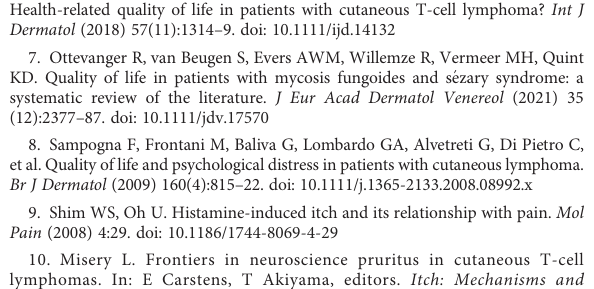
SUPPLEMENTARY FIGURE 1 Representative photos of a patient with mycosis fungoides. (A) An overview of a patient with MF and (B) A close-up of the arm, from which both skin biopsies of lesional and non-lesional skin were taken. SUPPLEMENTARY FIGURE 2 Mast cell numbers are increased in lesional skin of MF patients. Histological pictures of MC in Giemsa stainings are depicted of healthy control skin (A, B) , lesional skin (C, D) and non-lesional skin (E, F) of a representative MF patient. Pictures (A, C, E) are shown as 20 fold magni fi cation, pictures (B, D, F) in 40 fold magni fi cation of marked area. Arrows point towards MCs. SUPPLEMENTARY FIGURE 3 Postulated mechanism of pruritus induction in MF patients (1).Higher number of mast cells in the papillary dermis (2). Increased levels of tryptase in the skin (3). Tryptase-induced, PAR-2-mediated pruritus SUPPLEMENTARY TABLE 1 Correlation of MC numbers in skin with clinical markers of MF. MF, Mycosis fungoides; mSWAT, Modi fi ed Severity-Weighted Assessment Tool; BSA, Body surface area; PGA, Patient Global Assessment; QoL, Quality of Life; DLQI, Dermatology Life Quality Index; N, Number; R, Spearman ’ s R; for correlations the Spearman correlation was used SUPPLEMENTARY TABLE 1 Correlation of serological markers with clinical markers of MF. MF, Mycosis fungoides; MBP, Major Basic Protein; ECP, Eosinophil Cationic Protein; mSWAT, Modi fi ed Severity-Weighted Assessment Tool; BSA, Body surface area; PGA, Patient Global Assessment; QoL, Quality of Life; DLQI, Dermatology Life Quality Index; N, Number; R, Spearman ’ s R; for correlations the Spearman correlation was used. SUPPLEMENTARY TABLE 2 Comparison of serological and histological markers of MF patients and healthy controls. MF, Mycosis fungoides; MC, Mast cell; Eos, Eosinophils; MBP, Major Basic Protein; ECP, Eosinophil Cationic Protein; N, Number; IQR, Interquartile range; SD, Standard deviation; Continuous variables were compared using Wilcoxon rank test.; Number of patients: Serological markers N=10 and Histological parameters